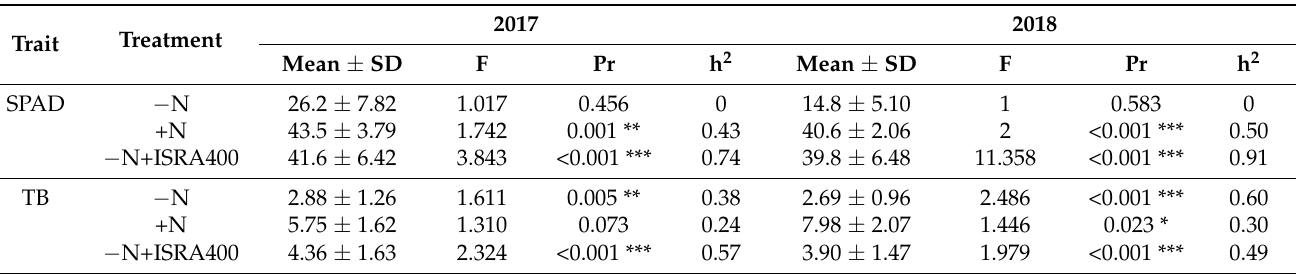
Table 1. Descriptive statistics and broad-sense heritability in 2017 and 2018 experiments for traits related to BNF: leaf chlorophyll content and total